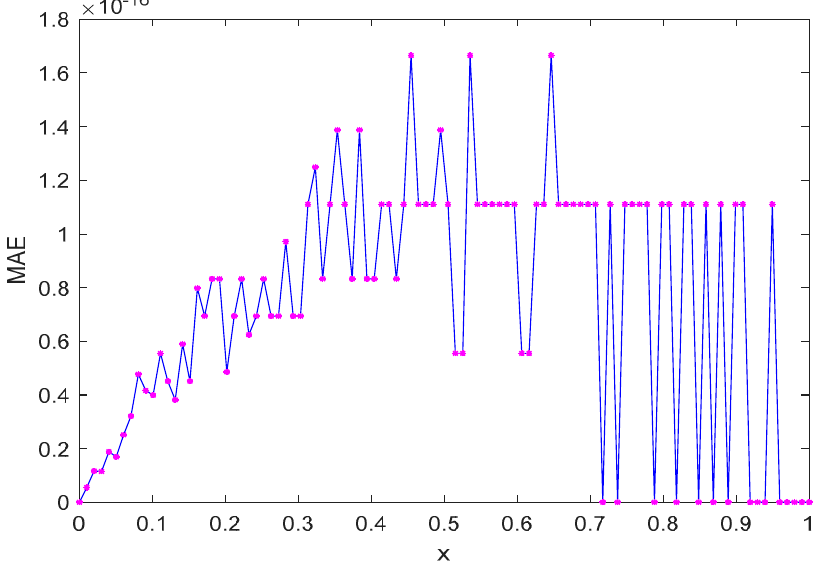
Figure 2. Plot of MAE of Example 1 for 𝑅 = 2 , and 𝛼 = (cid:2870)